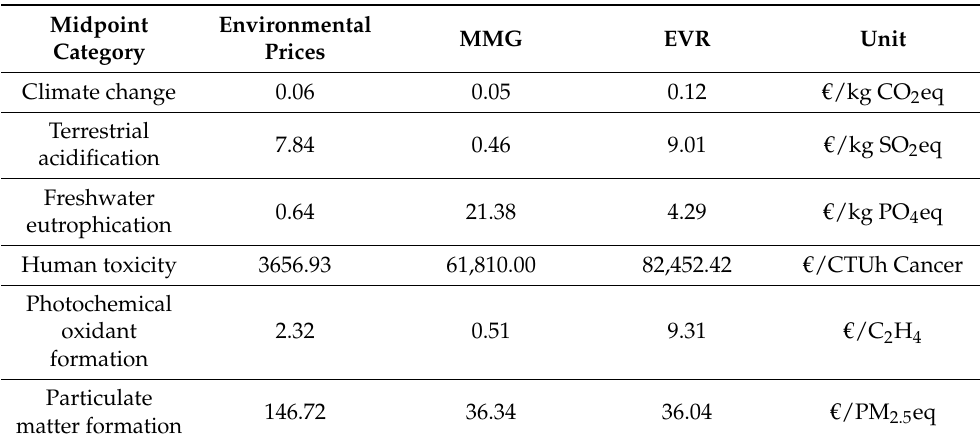
Table 6. Monetization